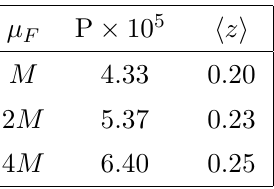
Table 2 . The fragmentation probability and average z value for D g → B ∗ ( z, µ F ) with three typical c factorization scales, where the strong coupling constant is fixed as α s (2 m c ) = 0 . 259 . µ (GeV) P ( B ,ours) P ( B ,ref. [23]) P ( B ∗ ,ours) c c F c